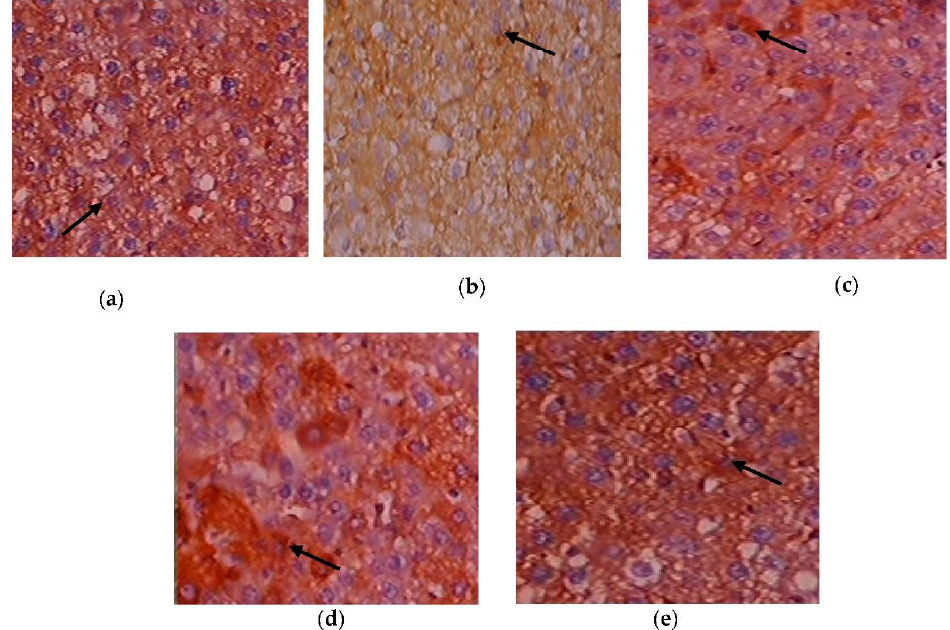
Figure 10. Expression of Akt via immunohistochemistry (100x). ( a ) Control rats; ( b ) T2DM rats; ( c ) C. papaya -treated T2DM rats; ( d ) metformin-treated T2DM rats; ( e ) C. papaya -treated control rats.